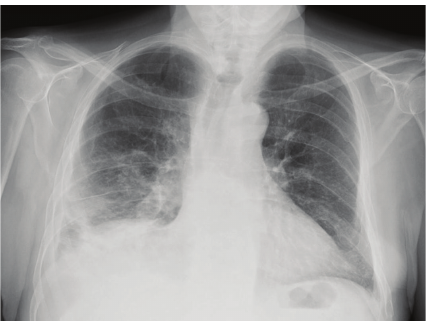
Figure 4: Control chest X-ray. Loss of volumen of the right lung and improvement of the right alveolar basal